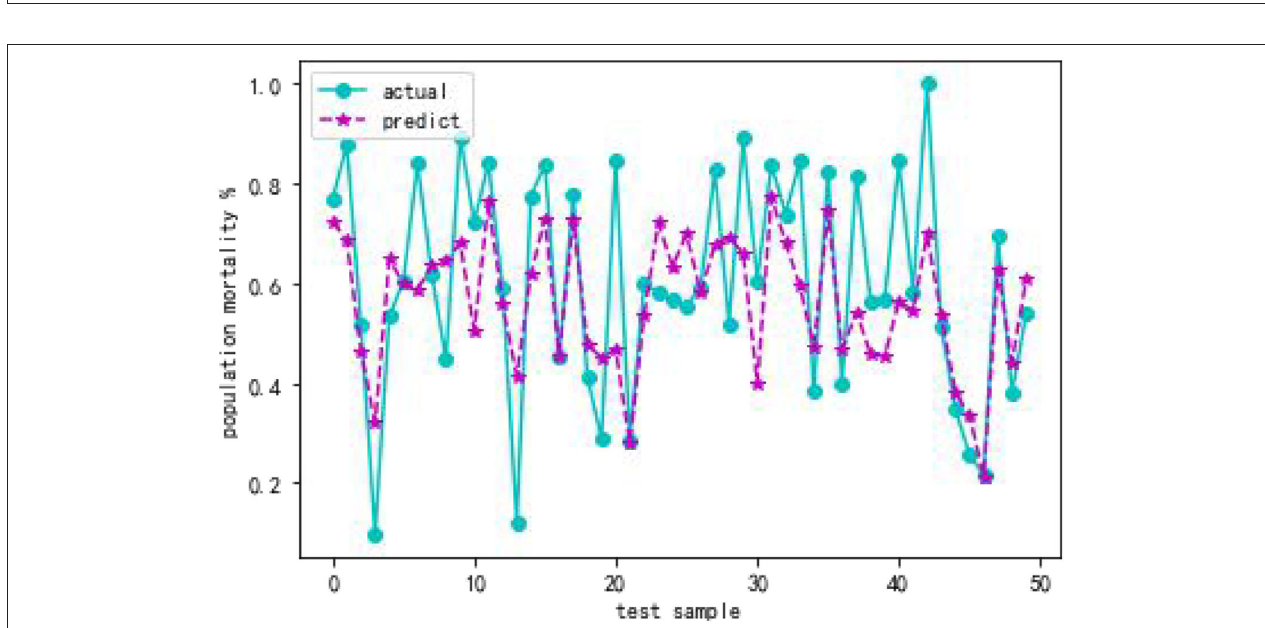
FIGURE 6 | Comparison of random forest model predicted value and actual